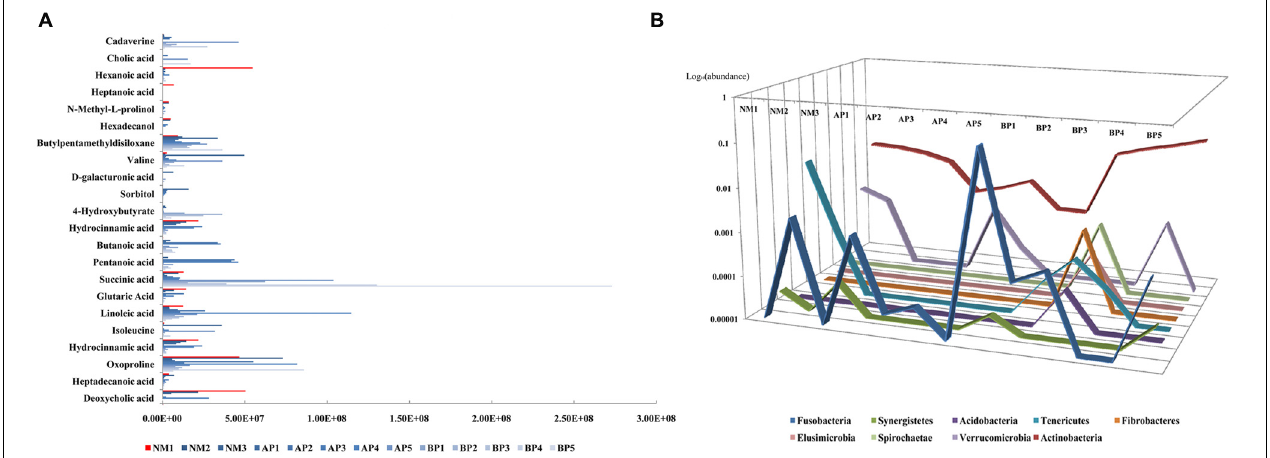
FIGURE 3 | The correlation analysis between the abundance of fecal metabolites (A) and fecal microbiota composition, with the data shown as logarithm value, (B) among the